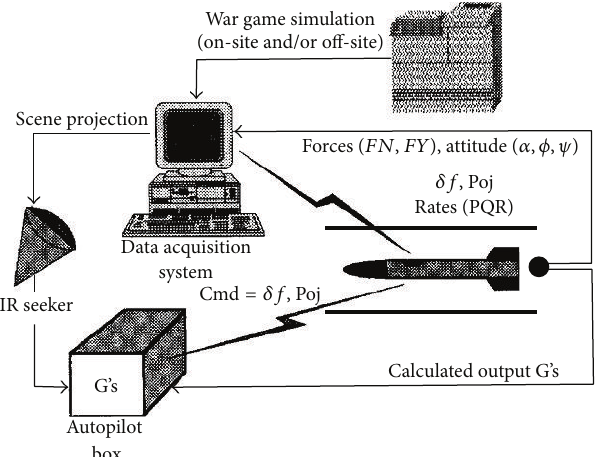
Figure 2: VFT scenario for evaluating guidance and control system of missiles [6].